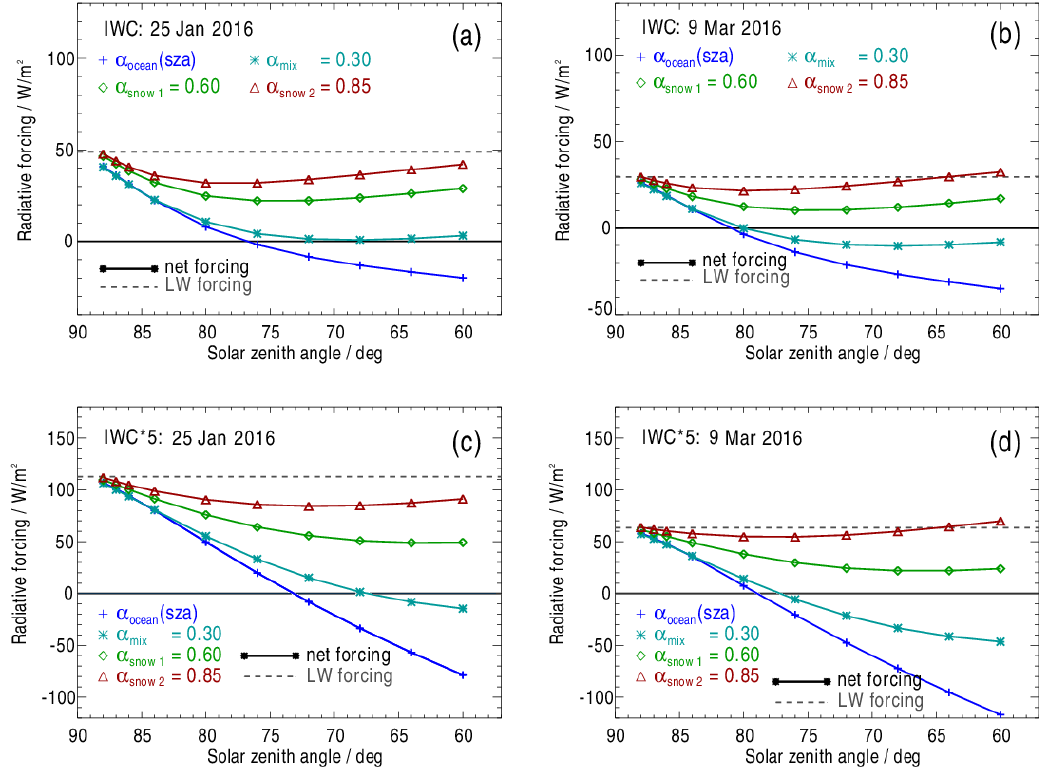
Figure 10. Radiative forcing at the top of the atmosphere as a function of the solar zenith angle on (a) 25 January 2016 and on (b) 9 March 2016 for different surface albedo assumptions as indicated. Panels (c) and (d) are the same as panels (a) and (b) respec- tively but for ice clouds with higher optical thicknesses obtained by multiplying the measured profile IWC( z ) by a factor of 5. Horizontal dashed lines, valid for ε = 1 . 0, indicate the LW component of the